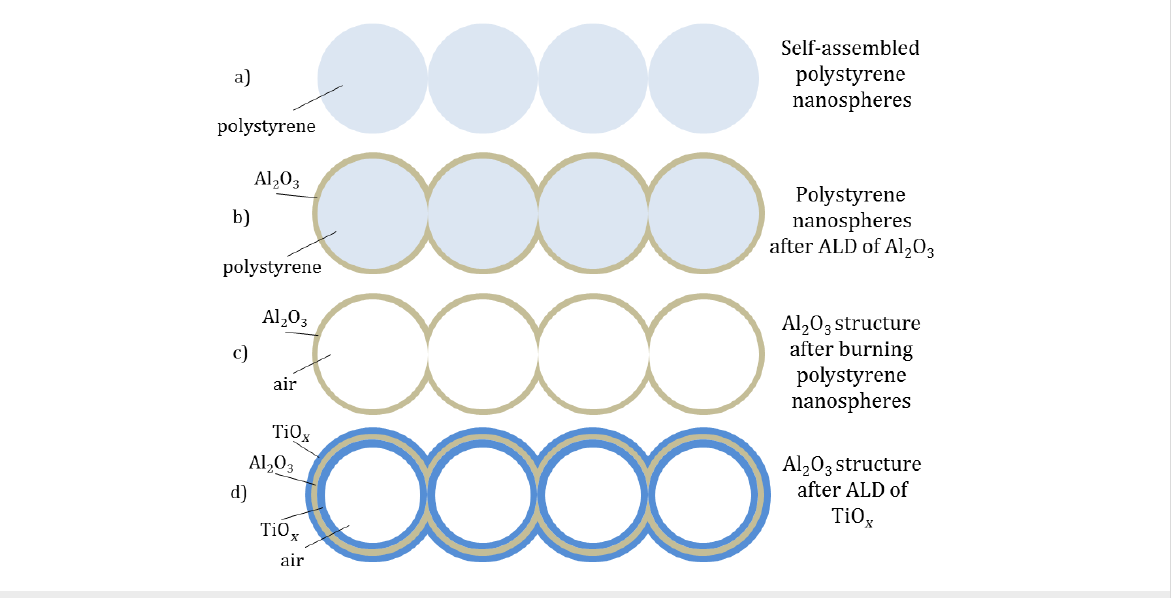
Figure 1: Schematic side view of the fabrication